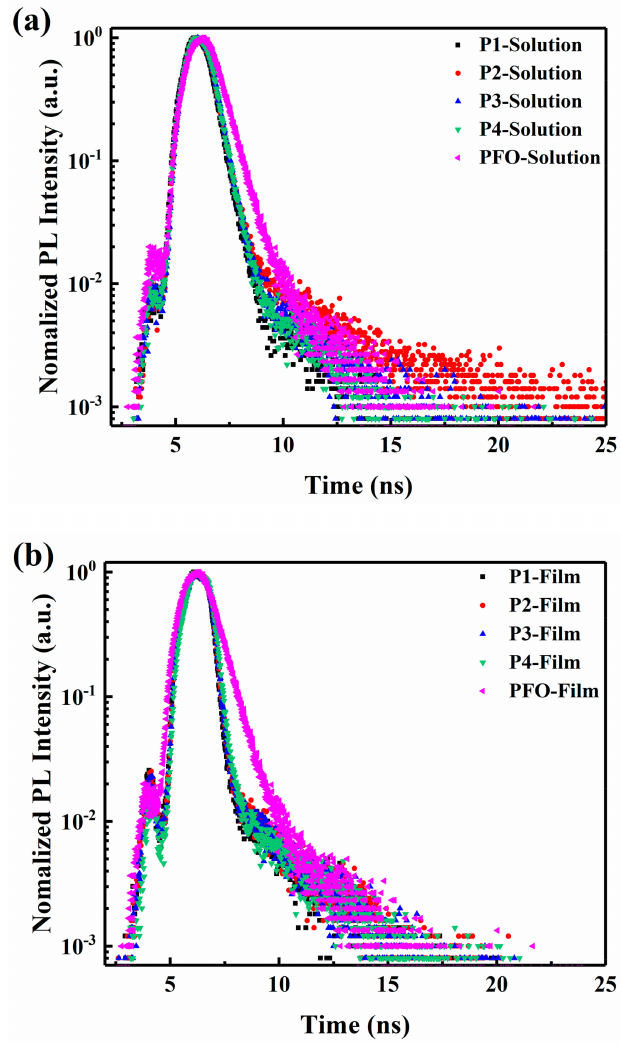
Figure 5. The time-resolved photoluminescence (PL) transients of P1–P4 and poly(9,9-dioctylfluorene) (PFO), ( a ) in Tetrahydrofuran(THF) solution (5 × 10 − 6 M), ( b ) in neat films ( λ ex = 375 nm, λ em = 423